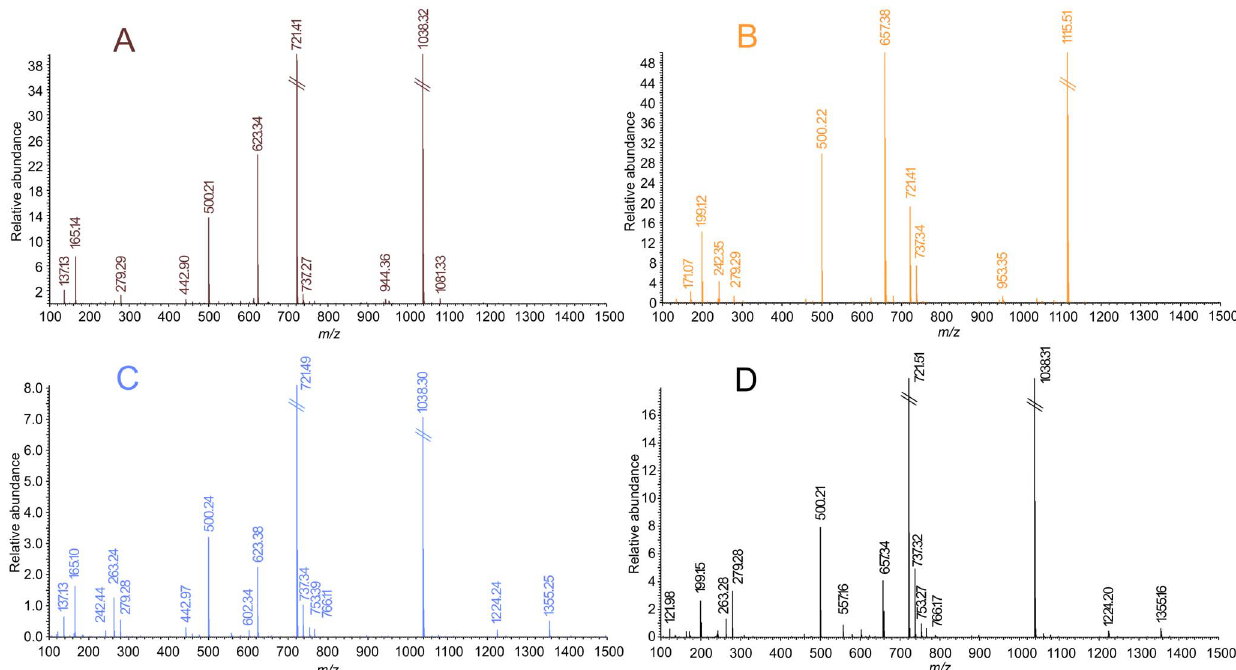
Figure 8. The results of the ESI-MS study of complex 1 (A) and 6 (B) solutions and interacting systems involving the mixture of physiological levels of cysteine and reduced glutathione and complex 1 (C) or complex 6 (D).